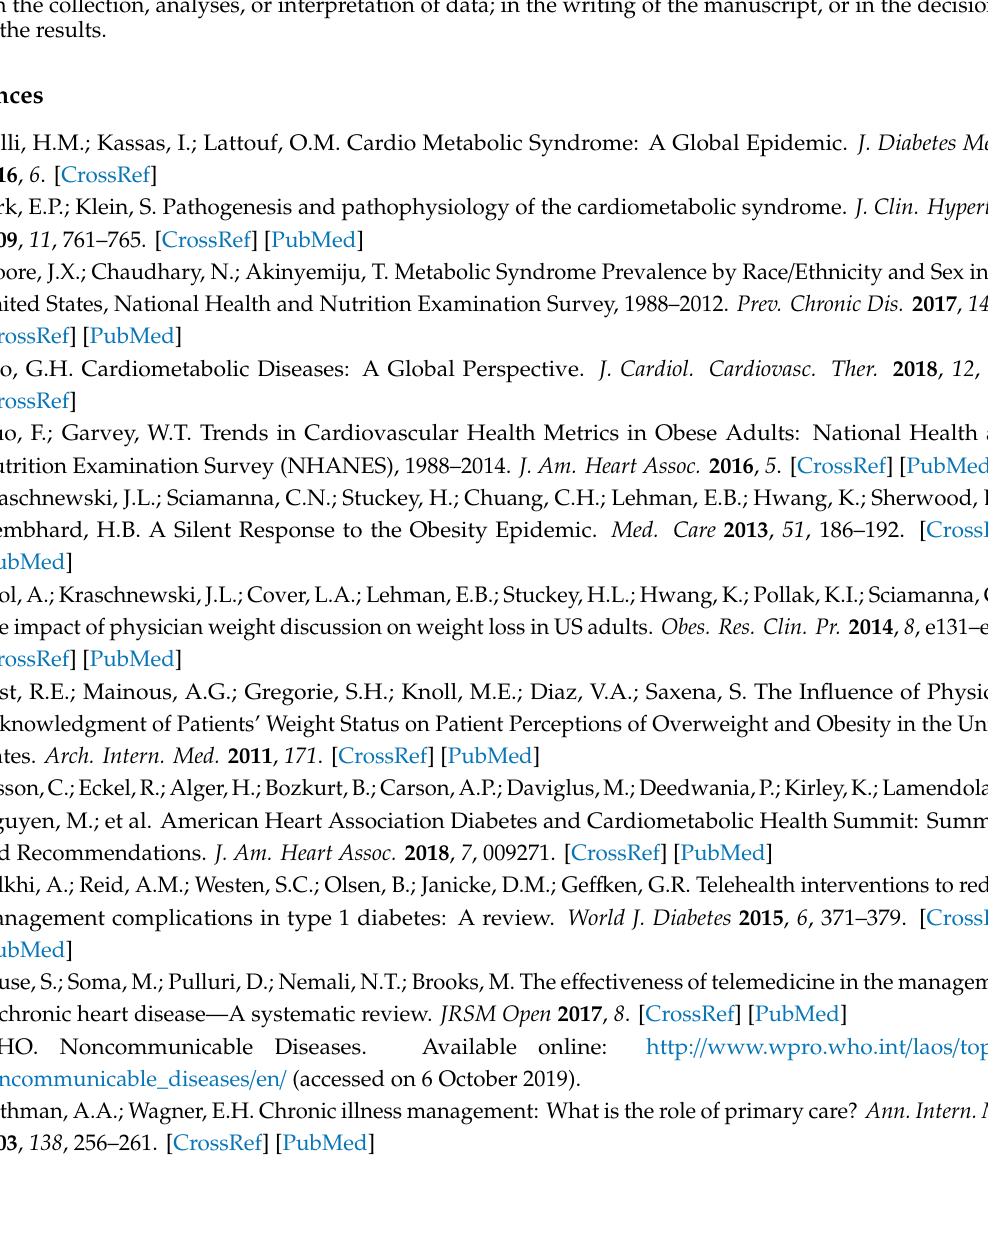
Table S1: Raw and multivariable adjusted p -values for Tables 4 and